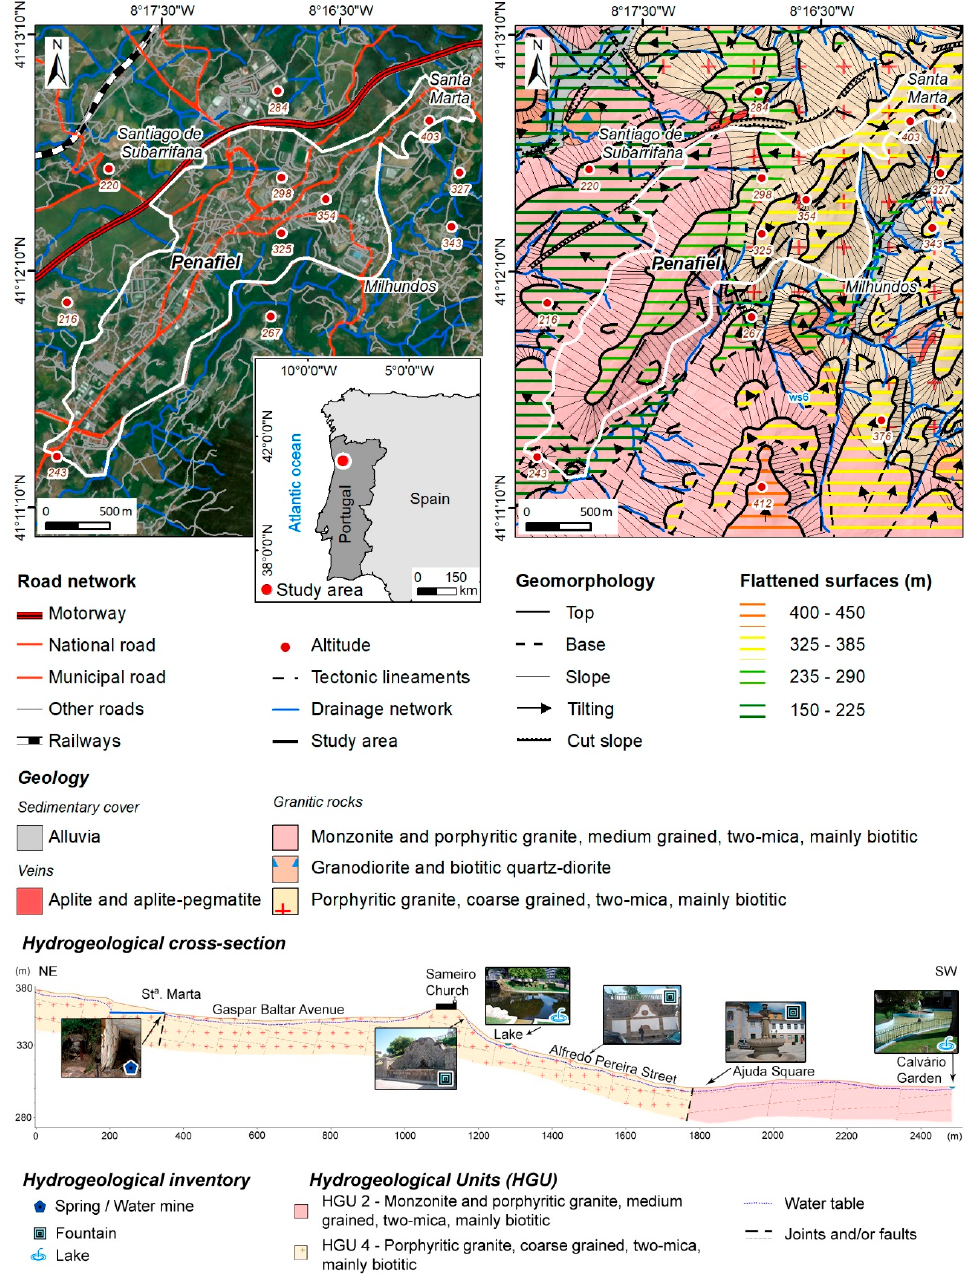
Figure 2. Geographical and geomorphological setting of the Penafiel urban area, as well as an interpretative hydrogeological cross-section of the studied area.